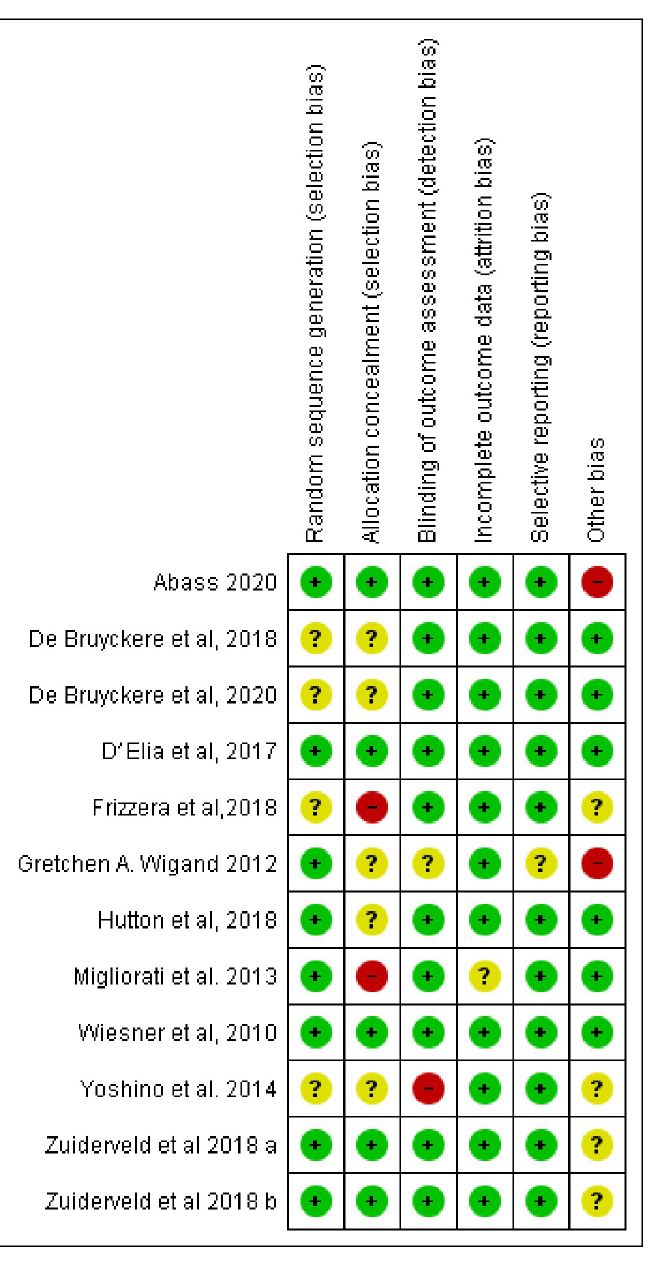
• One study (n = 60) [33] with 1-year follow-up compared two types of soft tissue augmenta- tion (SCTG and XCM) with no graft along with DIP in the preserved socket. After 12